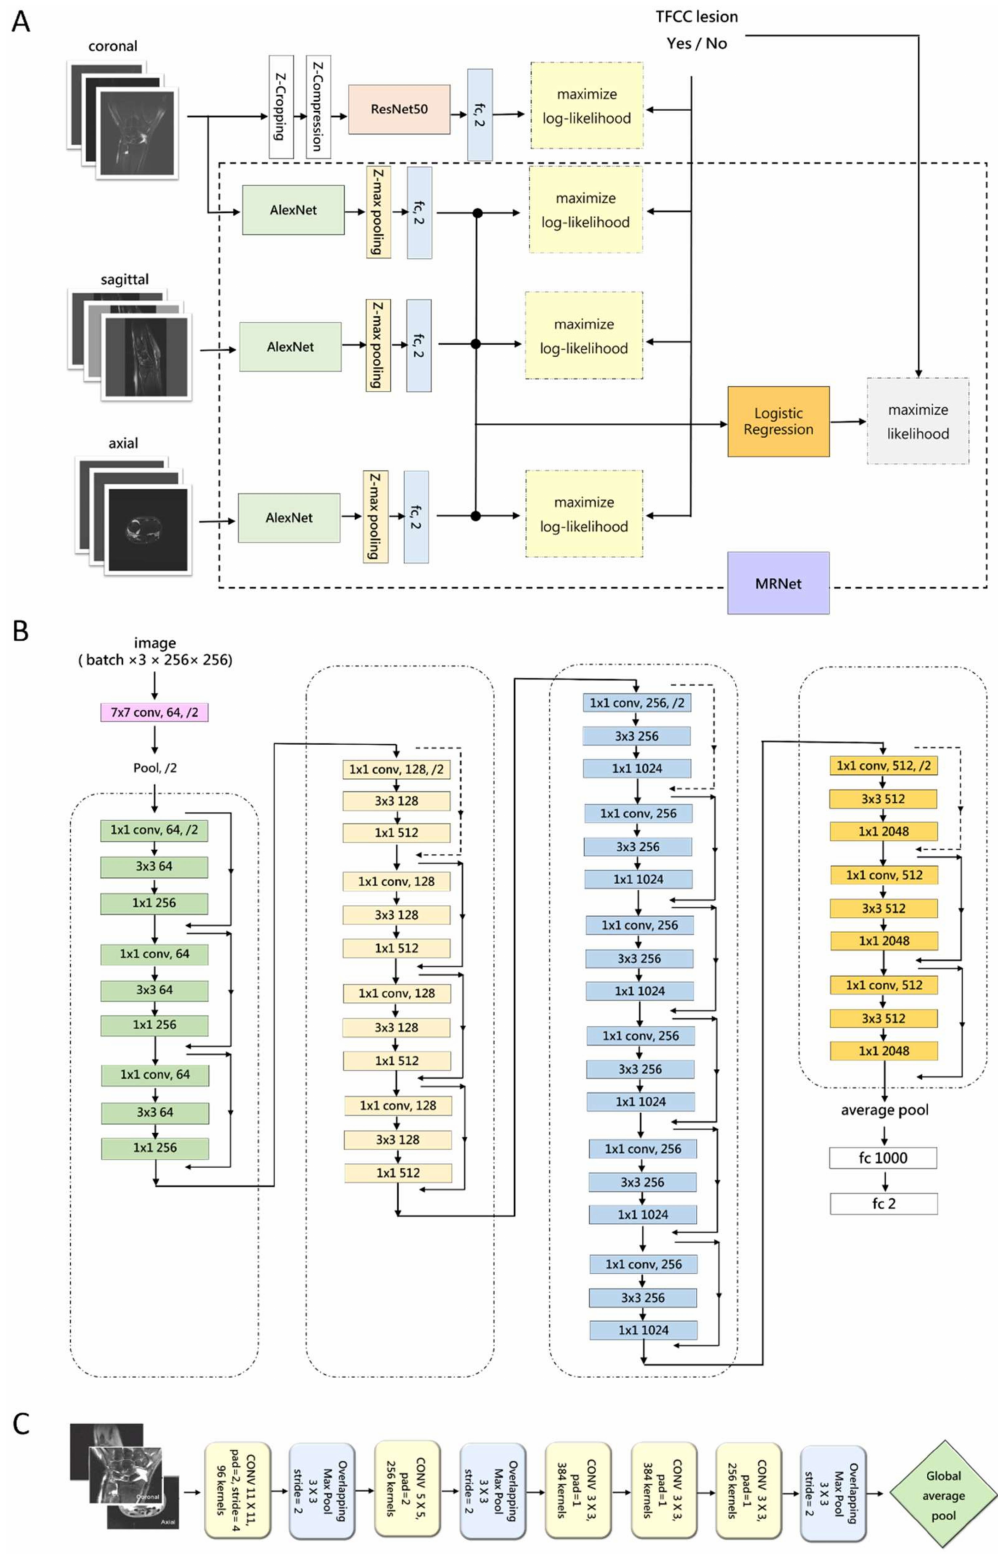
Figure 2. ( A ) An overview of both algorithms used in this study. The topmost data flow shows how Algorithm 1 (ResNet50) processes images along the coronal axis. ResNet50 itself was originally a model for processing 2D images. For ResNet50 to integrate the information from the z -axis, the MR images would first go through the z-direction cropping, which selects the middle eight of a set of